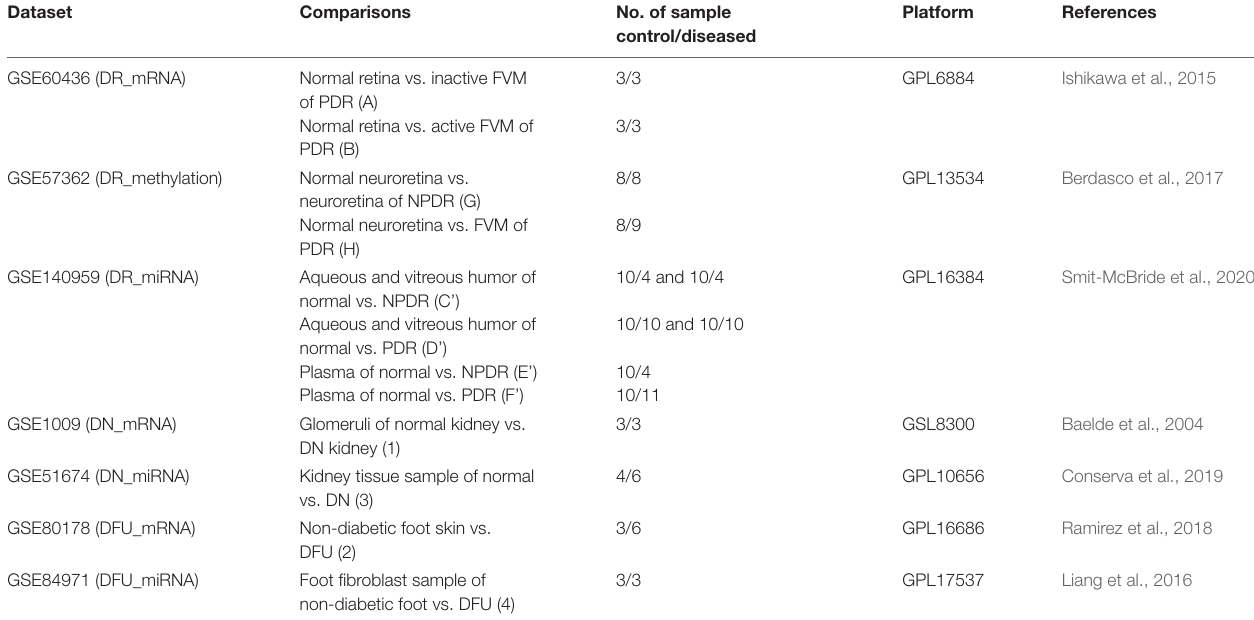
TABLE 1 | Datasets and the set of